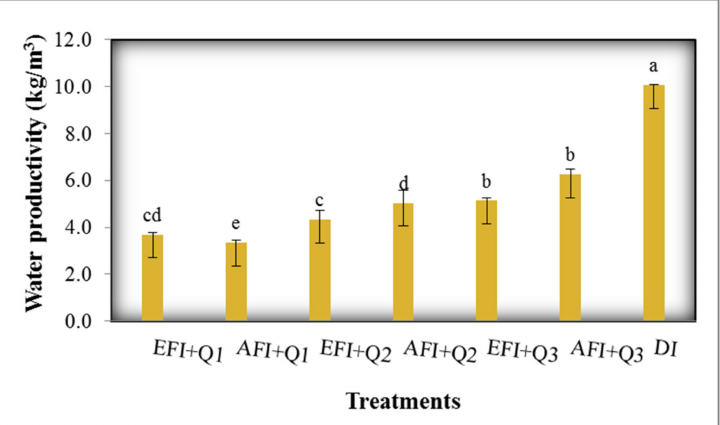
Figure 5. Effect of irrigation method (EF, AF, and DI) and flow rate (0.47 (Q1), 0.95 (Q2), and 1.43 L/s (Q3)) on the water productivity of cauliflower across the two seasons. Mean values followed by the same letter were not significantly different at the 5% level between treatments.